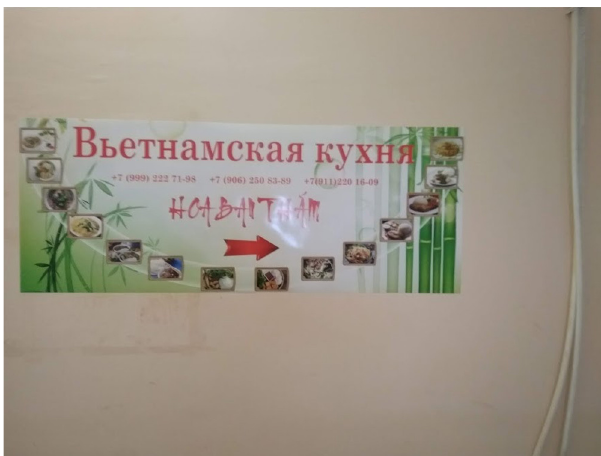
Figure 1: Signboard of a Vietnamese restaurant. Apraksin dvor, St. Petersburg, 2019, LinguaSnapp SPb.